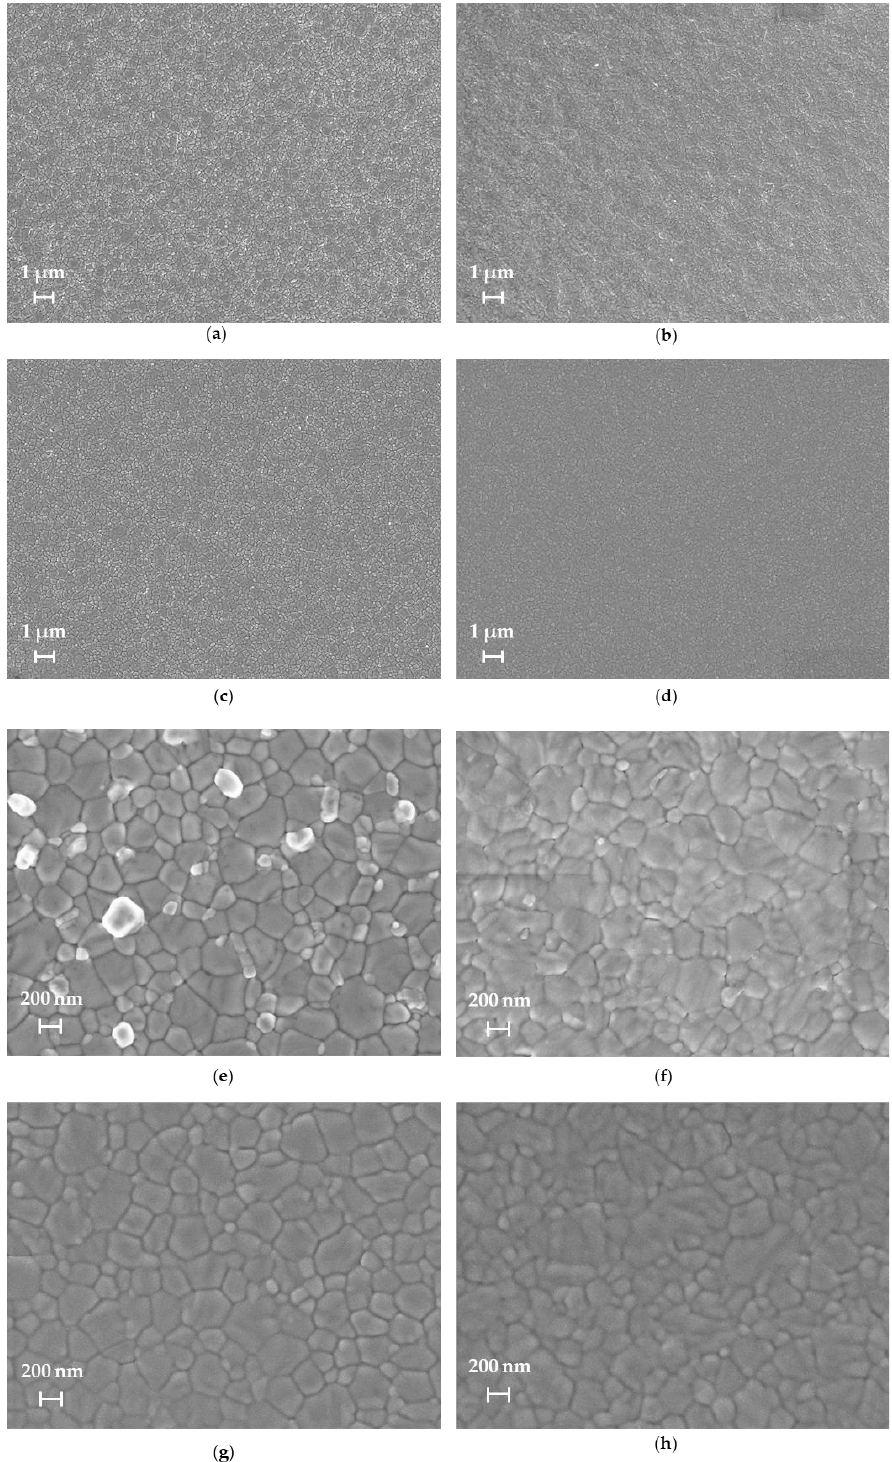
Figure 4. SEM images of: ( a , e ) pristine MAPbI 3 film; samples obtained by the plasma deposition of the fluorocarbon coating performed for ( b , f ) 10 s, ( c , g ) 30 s and ( d , h ) 60 s on the perovskite.